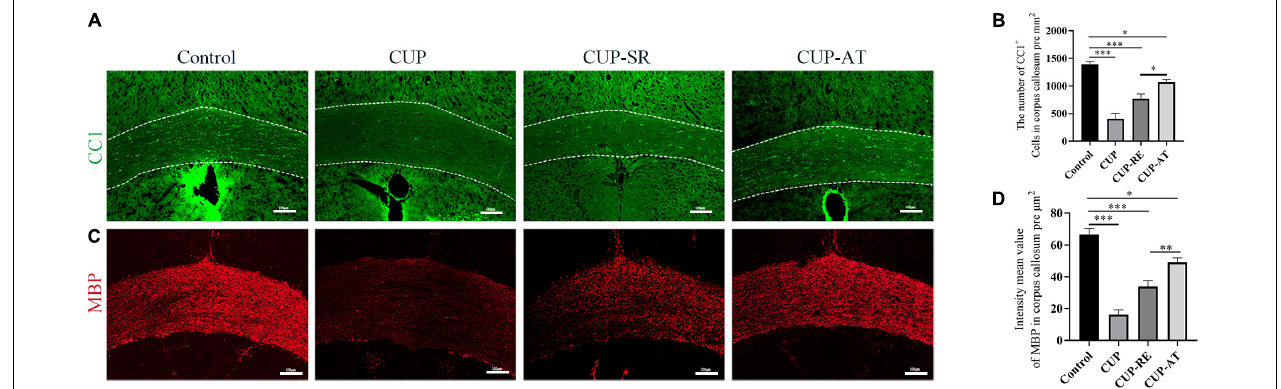
FIGURE 4 | CUP affects the maturation of oligodendrocytes in the corpus callosum, supplementation with Acer truncatum oil accelerated the maturation of oligodendrocytes and promoted remyelination. (A) CC1 immunofluorescence staining was performed in coronal slices of the corpus callosum in different groups. In control group, the CC1-positive mature oligodendrocytes in the corpus callosum were densely arranged, whereas the number of mature oligodendrocytes in the corpus callosum administrated with CUP significantly reduced. (B) Quantitative analysis of CC1-positive cells in the corpus callosum. The density of CC1-positive cells was significantly reduced in the CUP group. Dietary Acer truncatum oil significantly increased the number of CC1-positive cells. n = 4–6/group. (C) Fine MBP-positive fibers were well observed in the corpus callosum from control mice. In contrast, the mice exposed to CUP for 6 weeks showed widespread myelin breakdown. After dietary Acer truncatum oil, the MBP immunofluorescence staining recovered almost like that in control group. (D) Quantitative analysis of fluorescence intensity means the value of MBP in the corpus callosum. MBP expression in the corpus callosum was significantly decreased after CUP exposure, whereas Acer truncatum oil supplementation significantly increased MBP expression. n = 8/group. Scale bar: 100 µ m. Data were expressed as means ± SEM. Differences between groups were expressed as ∗ p < 0.05, ∗∗ p < 0.01, ∗∗∗ p <